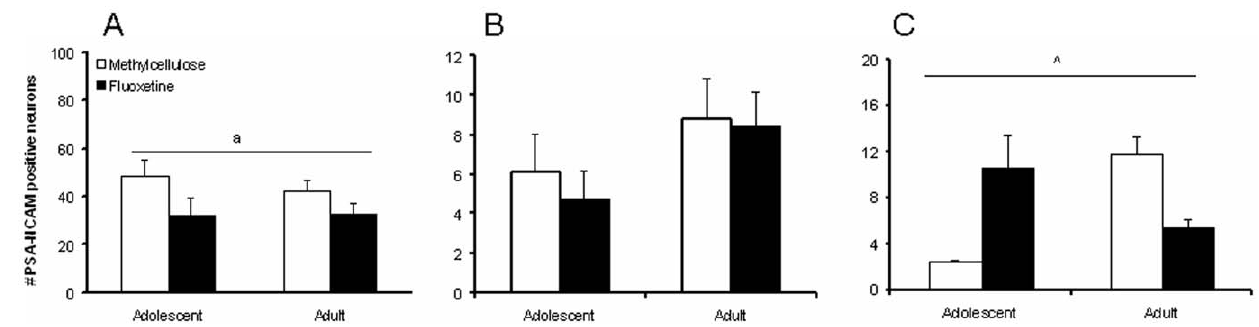
Figure 8. PSA-NCAM immunoreactivity in the dorsal raphe nucleus, mPFC, and amygdala of fluoxetine and methylcellulose treated adolescent and adult rats. Data are presented as mean 6 S.E.M. of the numer of immunoreactive neurons in the dorsal raphe nucleus (A), mPFC (B), and amygdala (C) (n=4–5) per 100 6 100 m m. 14–17 Days following chronic fluoxetine (12 mg/kg) treatment the number of PSA-NCAM immunoreactivity was lower in adult compared to adolescent rats, but only in the dorsal raphe nucleus. In addition, we obtained a significant age x treatment interaction for PSA-NCAM immunoreactivity in the amygdala, which tended to be increased in adolescent, and decreased in adult rats. a p , 0.05 main age effect; ‘ p , 0.05 age x treatment